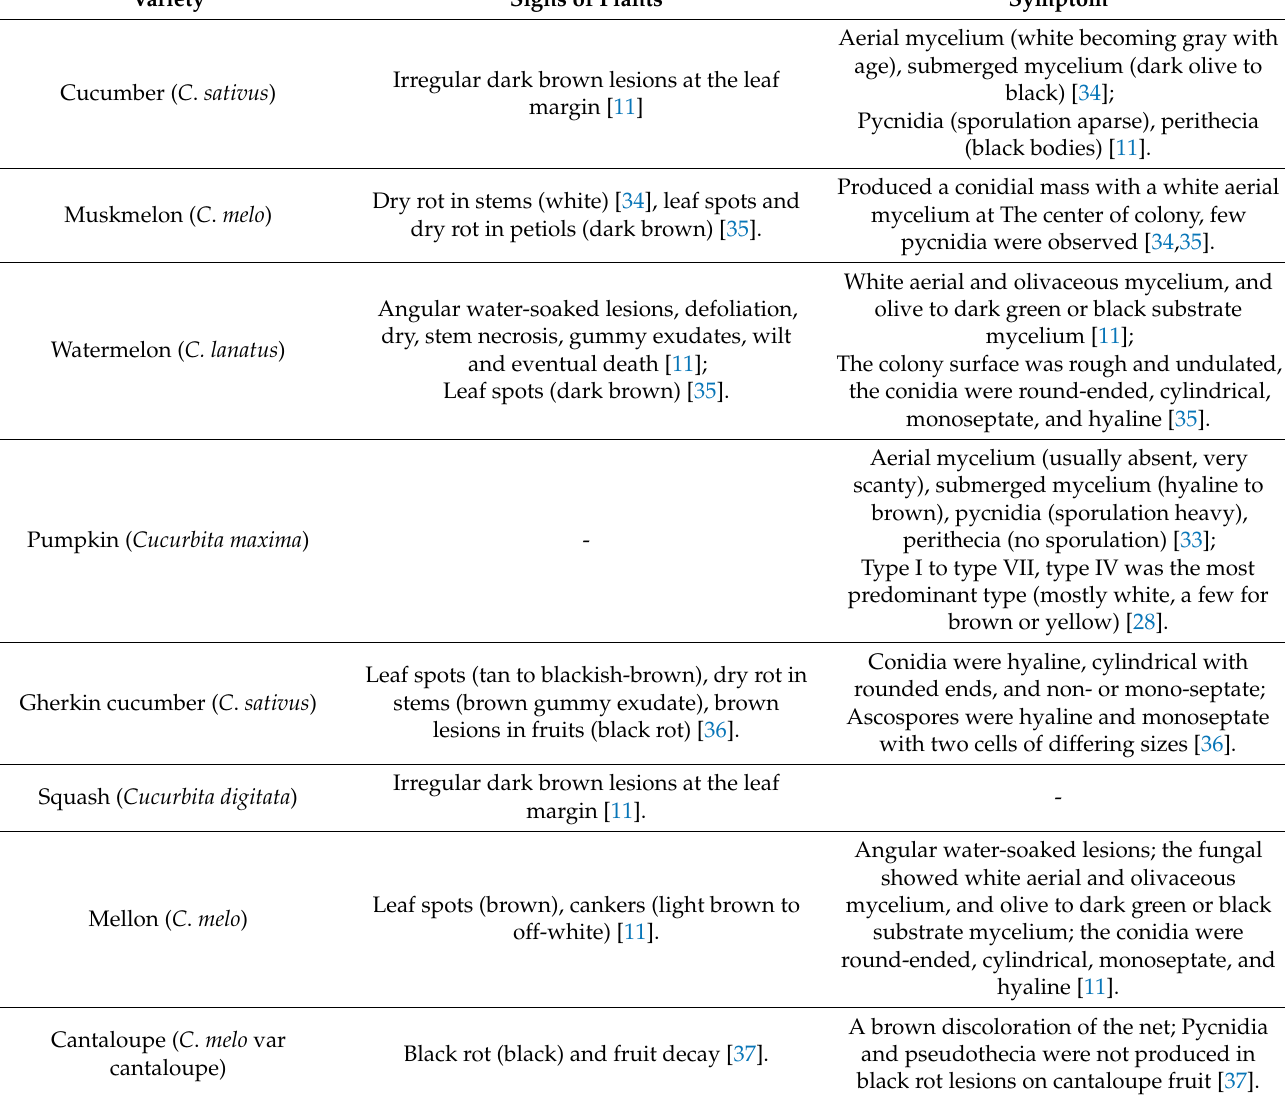
Table 1. Morphological and cultural characters of pathogenic bacteria on